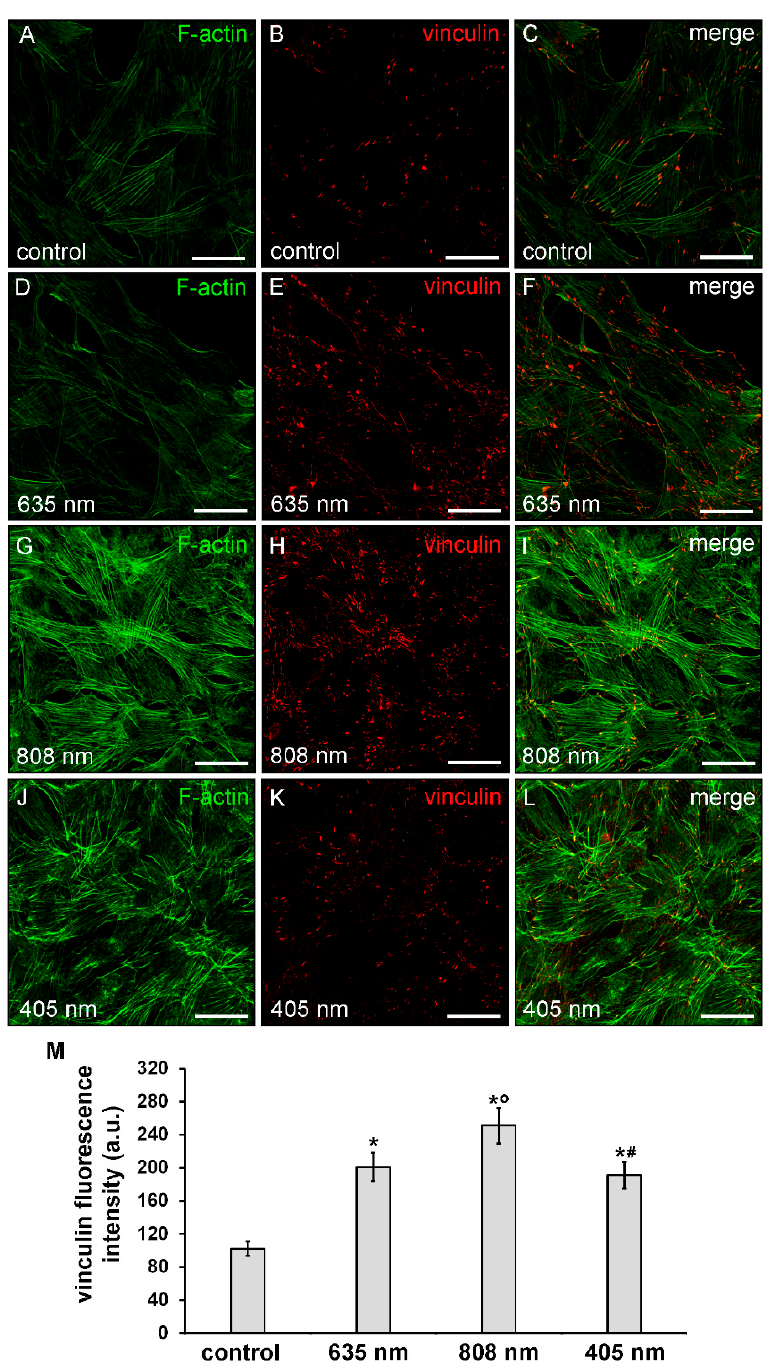
Figure 5. Confocal immunofluorescence analysis of F-actin cytoskeleton and focal adhesion plaque assembly of NIH / 3T3 fibroblasts performed 24 h after cell exposure to red (635 nm), NIR (808 nm) and violet-blue (405 nm) PBM. Cells not subjected to PBM treatments served as control. ( A – L ) Representative confocal fluorescence micrographs of fixed cells immunostained to detect vinculin (red) and incubated with Alexa 488-labeled phalloidin to label F-actin (green). Scale bar: 50 µ m. ( M ) Histogram showing the densitometric analysis of vinculin fluorescence intensity carried out on digitized images. Significance of difference: * p = 0.001 vs . control; ○ p = 0.001 vs. 635 nm; # p = 0.001 vs . 808 nm; p = 0.51, 405 nm vs. 635 nm.